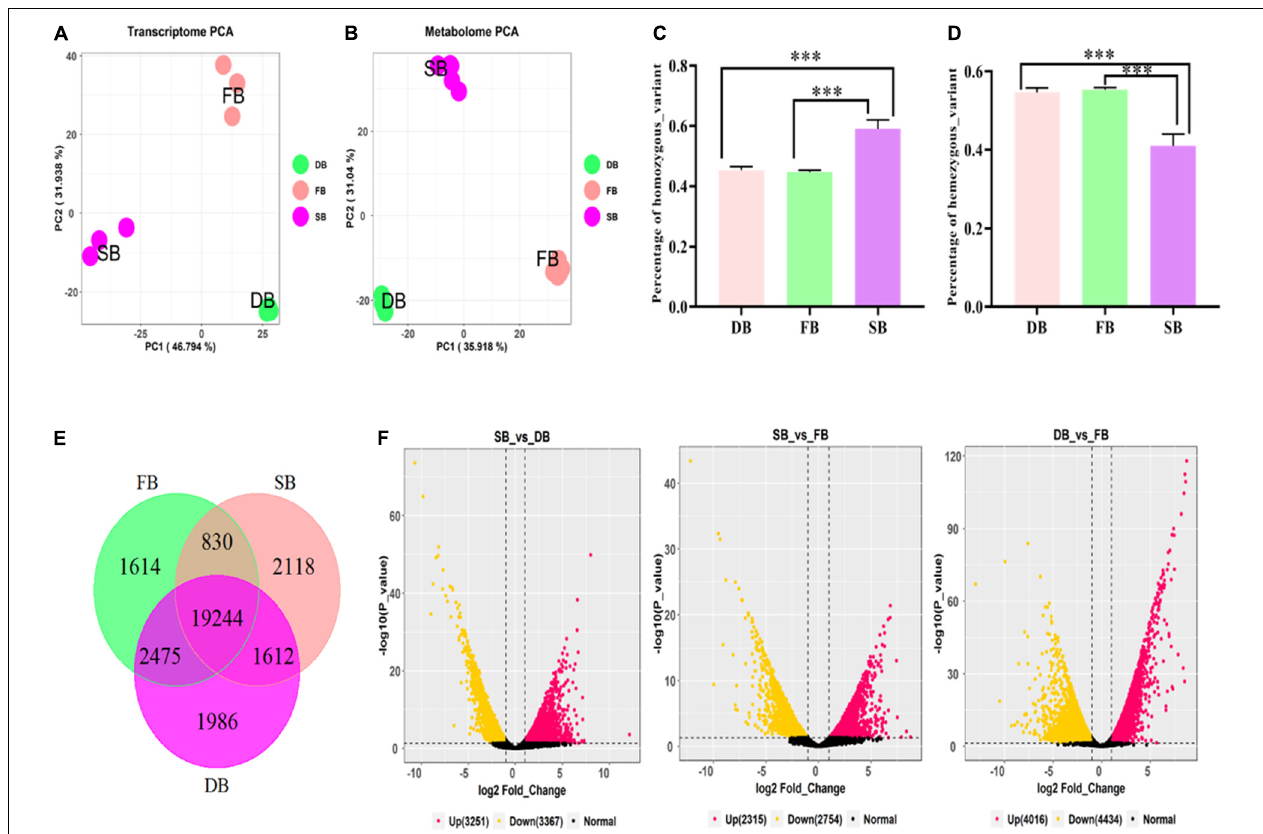
FIGURE 2 | Transcriptomic analysis of SB, FB, and DB tissues of tea plants. (A) PCA analysis of gene expression. (B) PCA analysis of metabolite content. Statistical analysis of homozygous SNPs (C) and heterozygous SNPs (D) in SB, FB, and DB. (E) Venn diagram of distribution of genes expressed in the three tissues. (F) Volcano plots of DEGs in the three